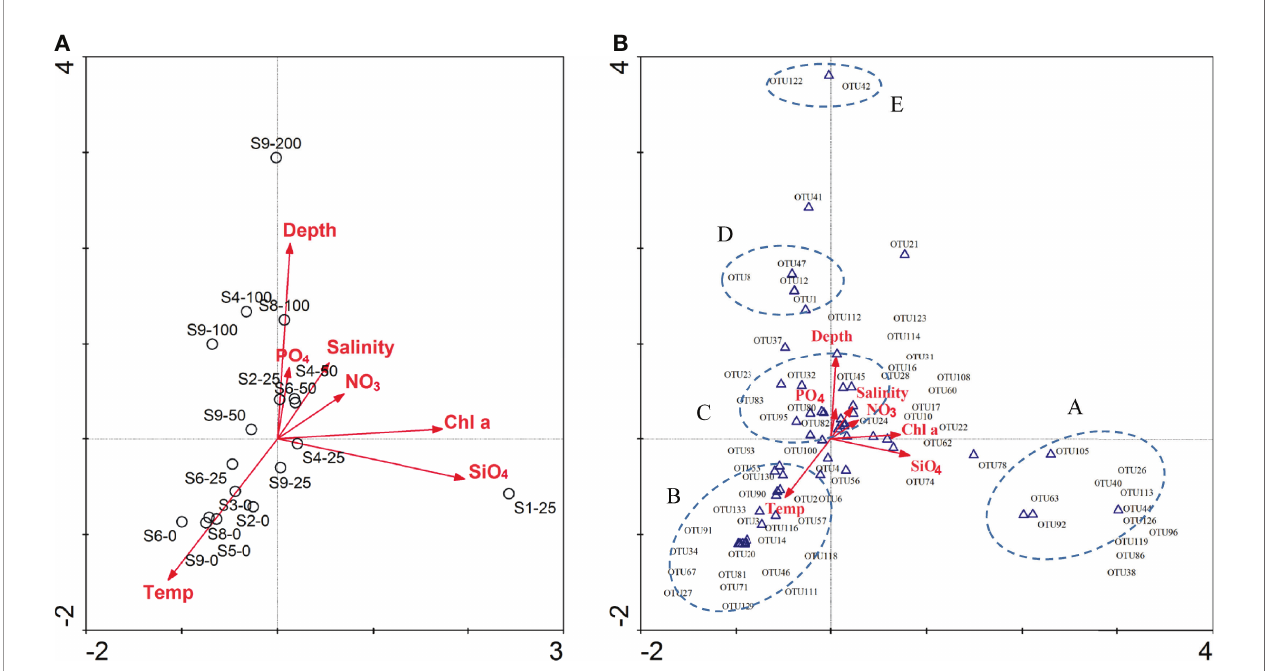
FIGURE 6 | Canonical correspondence analysis (CCA) of the relationship of dmdA gene diversity (A) and OTU level (B) in the Roseobacter group, with environmental factors. Areas surrounded by the blue dashed lines represented the dominant OTUs of different